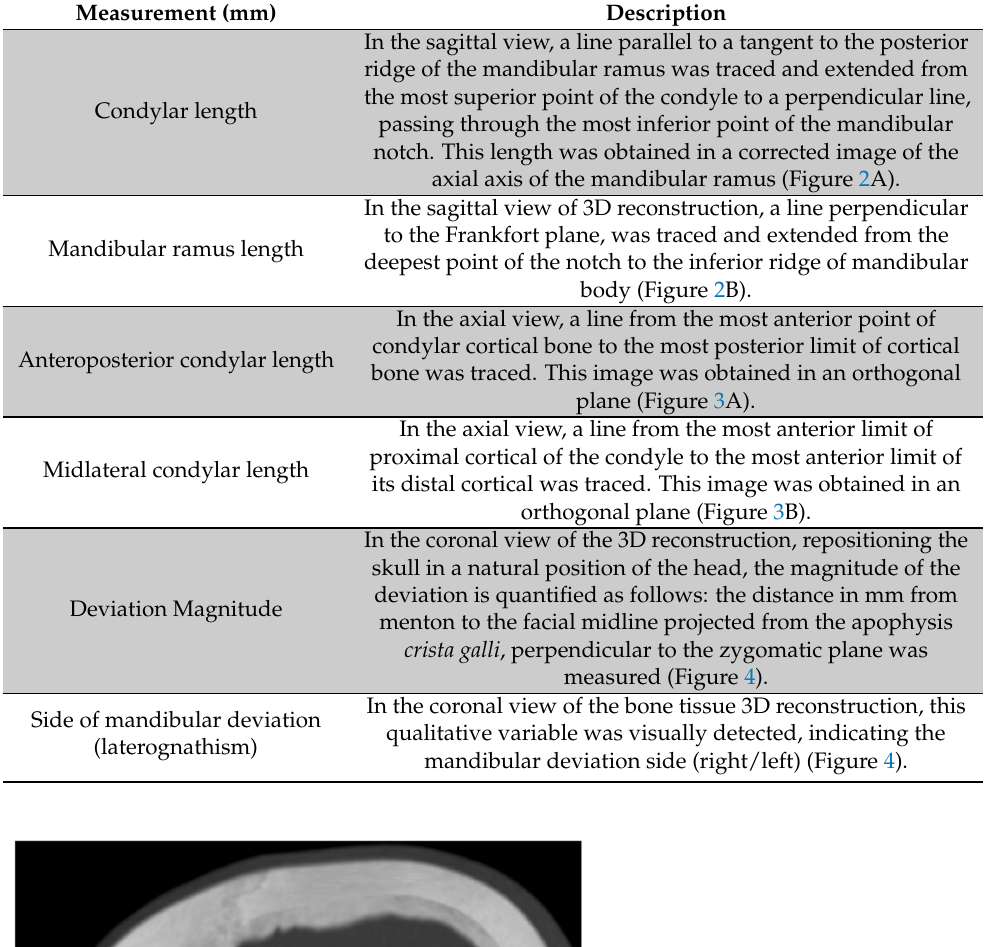
Table 1. Description of craniofacial measurements taken in the 3D bone tissue reconstruction, frontal, and sagittal planes.